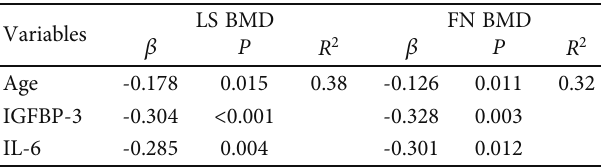
Figure 2: Correlations of LS BMD and FN BMD with IGFBP-3 and IL-6 in all postmenopausal women. LS: lumbar spine; FN: femoral neck. Table 2: Stepwise multiple regression analysis between age, BMI, IGFBP-3, and IL-6 considering LS/FN BMD as dependent